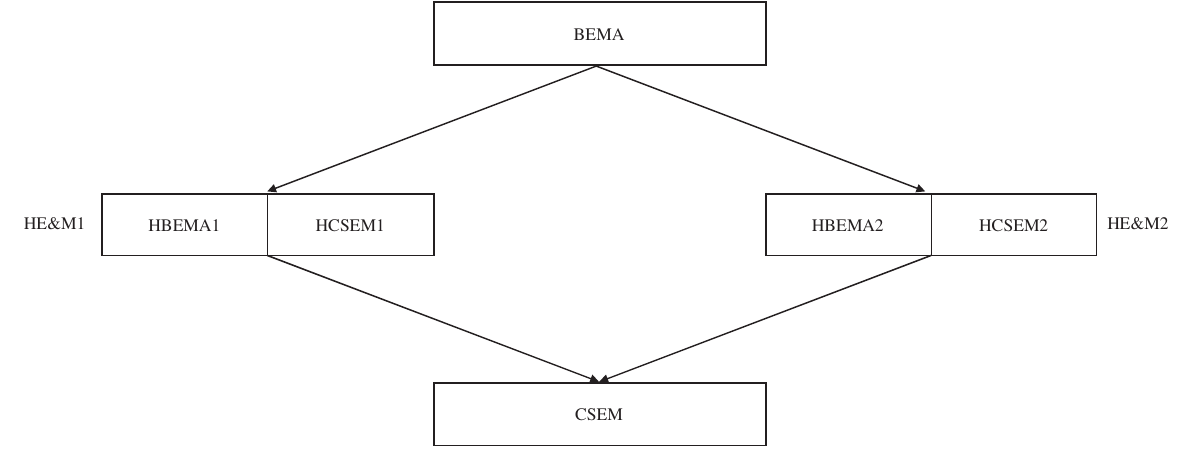
FIG. 1. Linking plan for linking the BEMA and